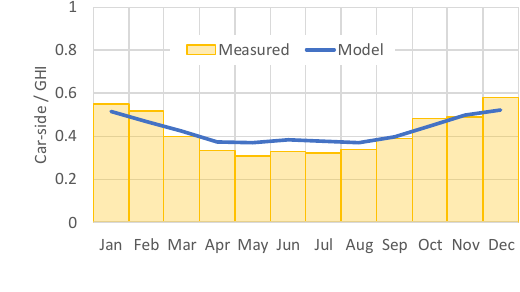
Figure 15. Monthly-based comparison between the measured solar irradiance around the car (bar-chart) and modeled (typical year from the METPV-11 solar database, namely, MEteorological Test data for PhotoVoltaic system) solar irradiance on the car (line-chart): ( a ) car roof irradiance; ( b ) car side irradiance.